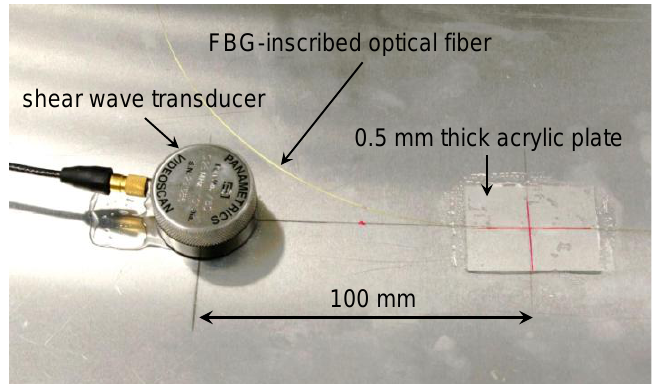
Figure 5. Photograph showing the installation of a mobile FBG